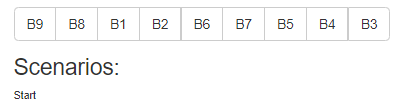
Figure 4. Recommended order of activities for the first scenario of process execution.